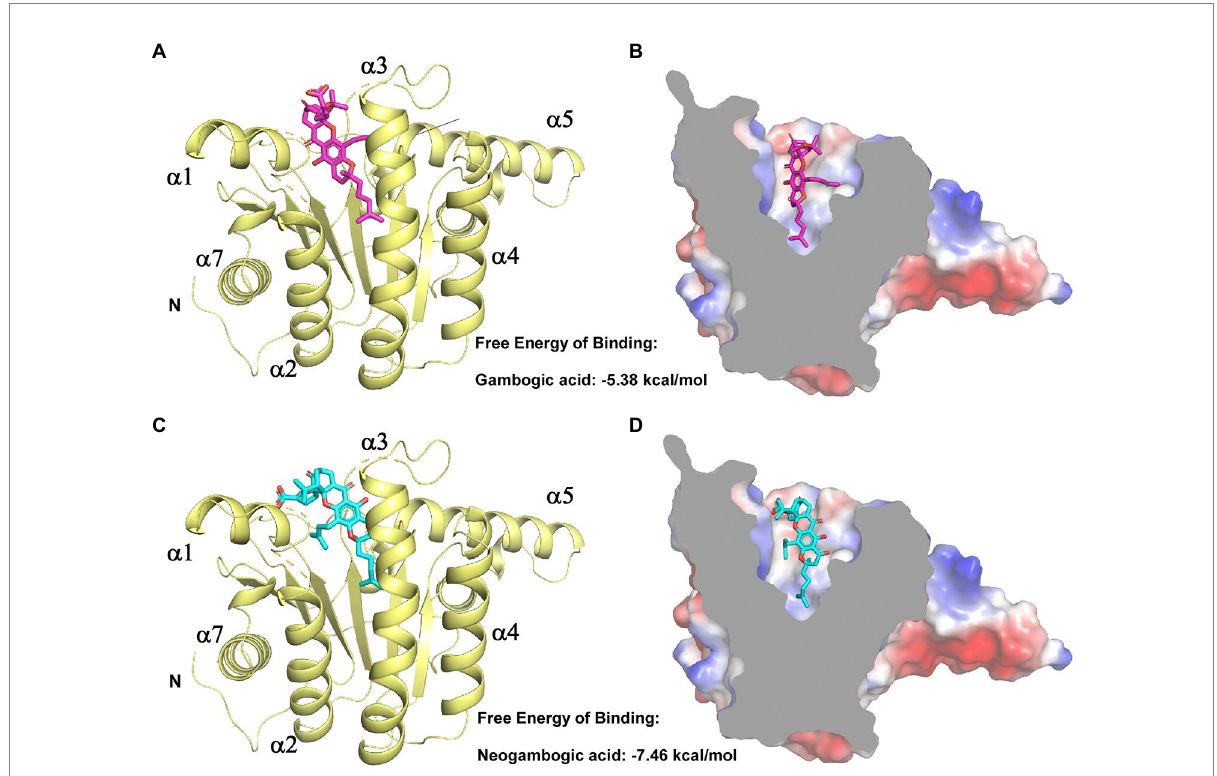
FIGURE 4 Molecular docking of GA and NGA with Efa UPPS. (A,C) Energetically favorable docking models of GA or NGA to Efa UPPS (PDB ID: 6LOI): purple, GA carbon atoms; cyan, NGA carbon atoms; red, oxygen atoms; blue, nitrogen atoms. (B,D) Surface electrostatic potential of Efa UPPS in complex with GA or NGA. Colors of compound models are the same as those in part (A,C)